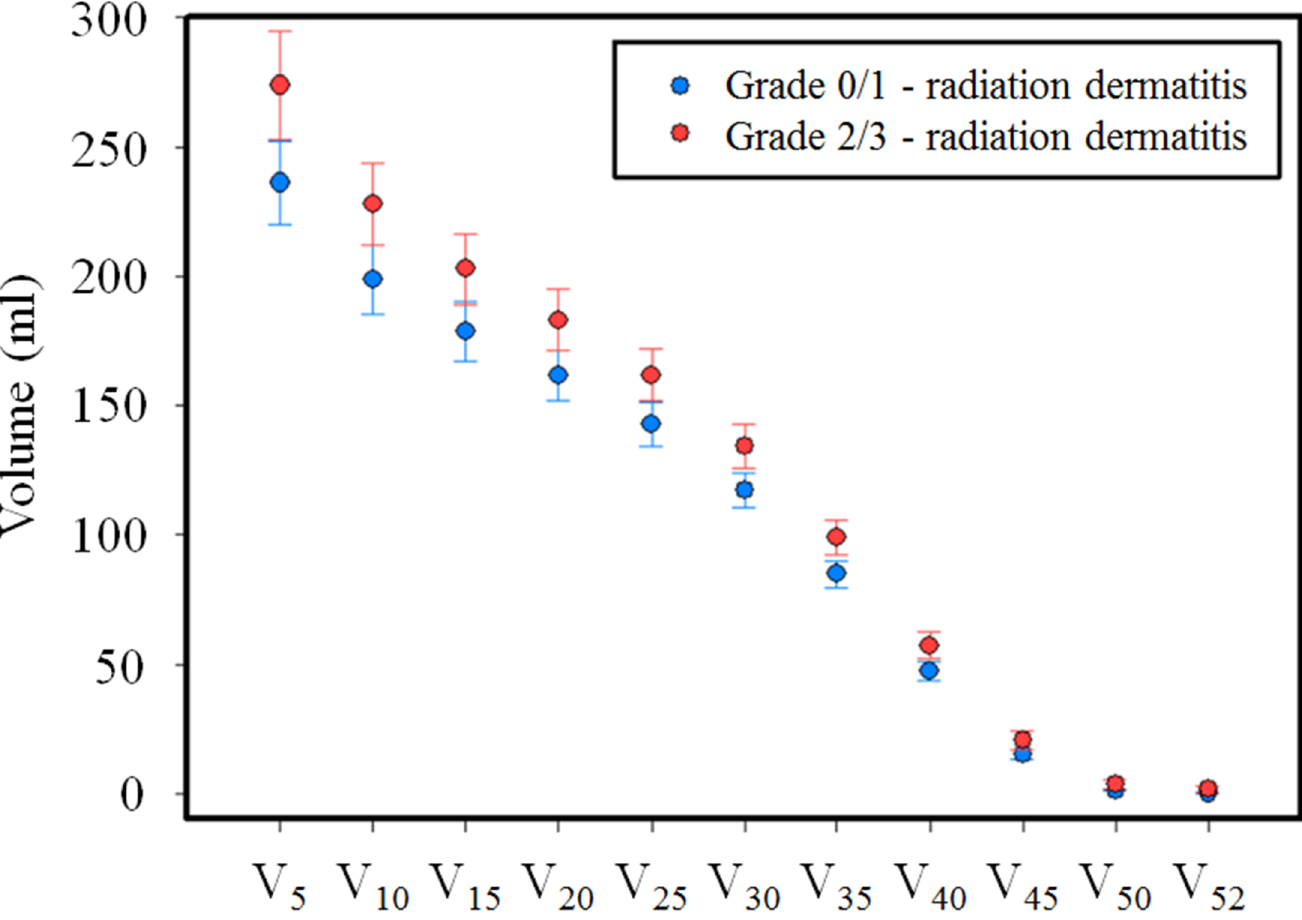
Fig 1. Comparison of the mean skin dose-volume histograms of patients with and without radiation dermatitis (RD) grade 2 + toxicity. Blue line = RD grade (cid:20) 1; red line = RD grade (cid:21) 2. V X is the irradiation dose to the skin (5, 10, 15, 20, 25, 30, 35, 40, 45, 50, or 52 Gy).